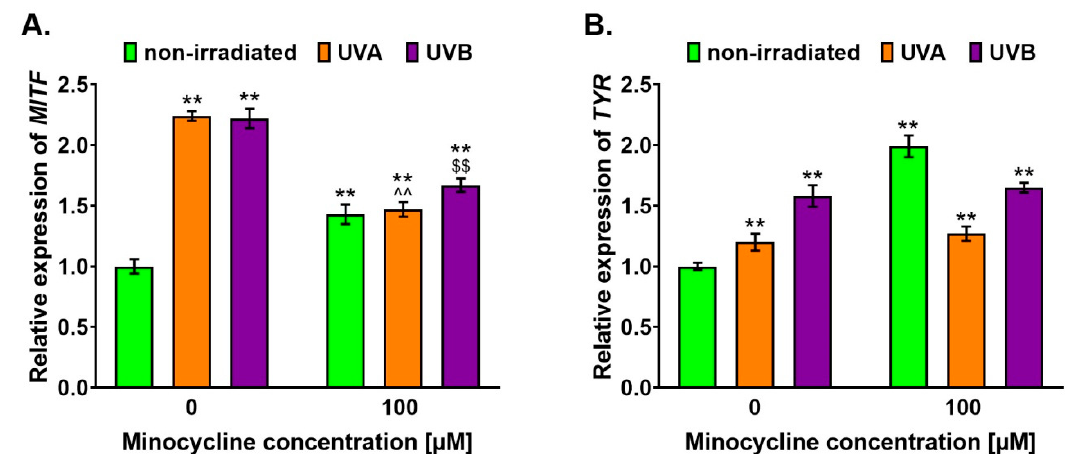
Figure 4. The influence of minocycline as well as UVA and UVB radiation on ( A ) MITF and ( B ) TYR expression in human normal melanocytes. The analysis was made using the RT-qPCR technique. GAPDH expression was used to normalize the obtained results. Transcriptional activity is presented as a relative expression level. ** p < 0.005 vs. non-irradiated cells; ^^ p < 0.005 vs. UVA-irradiated cells; $$ p < 0.005 vs. UVB-irradiated cells.